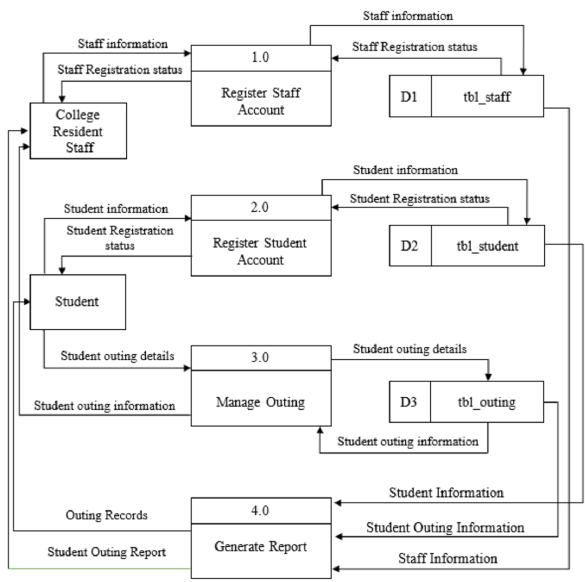
Figure 2. Data Flow Diagram (DFD).